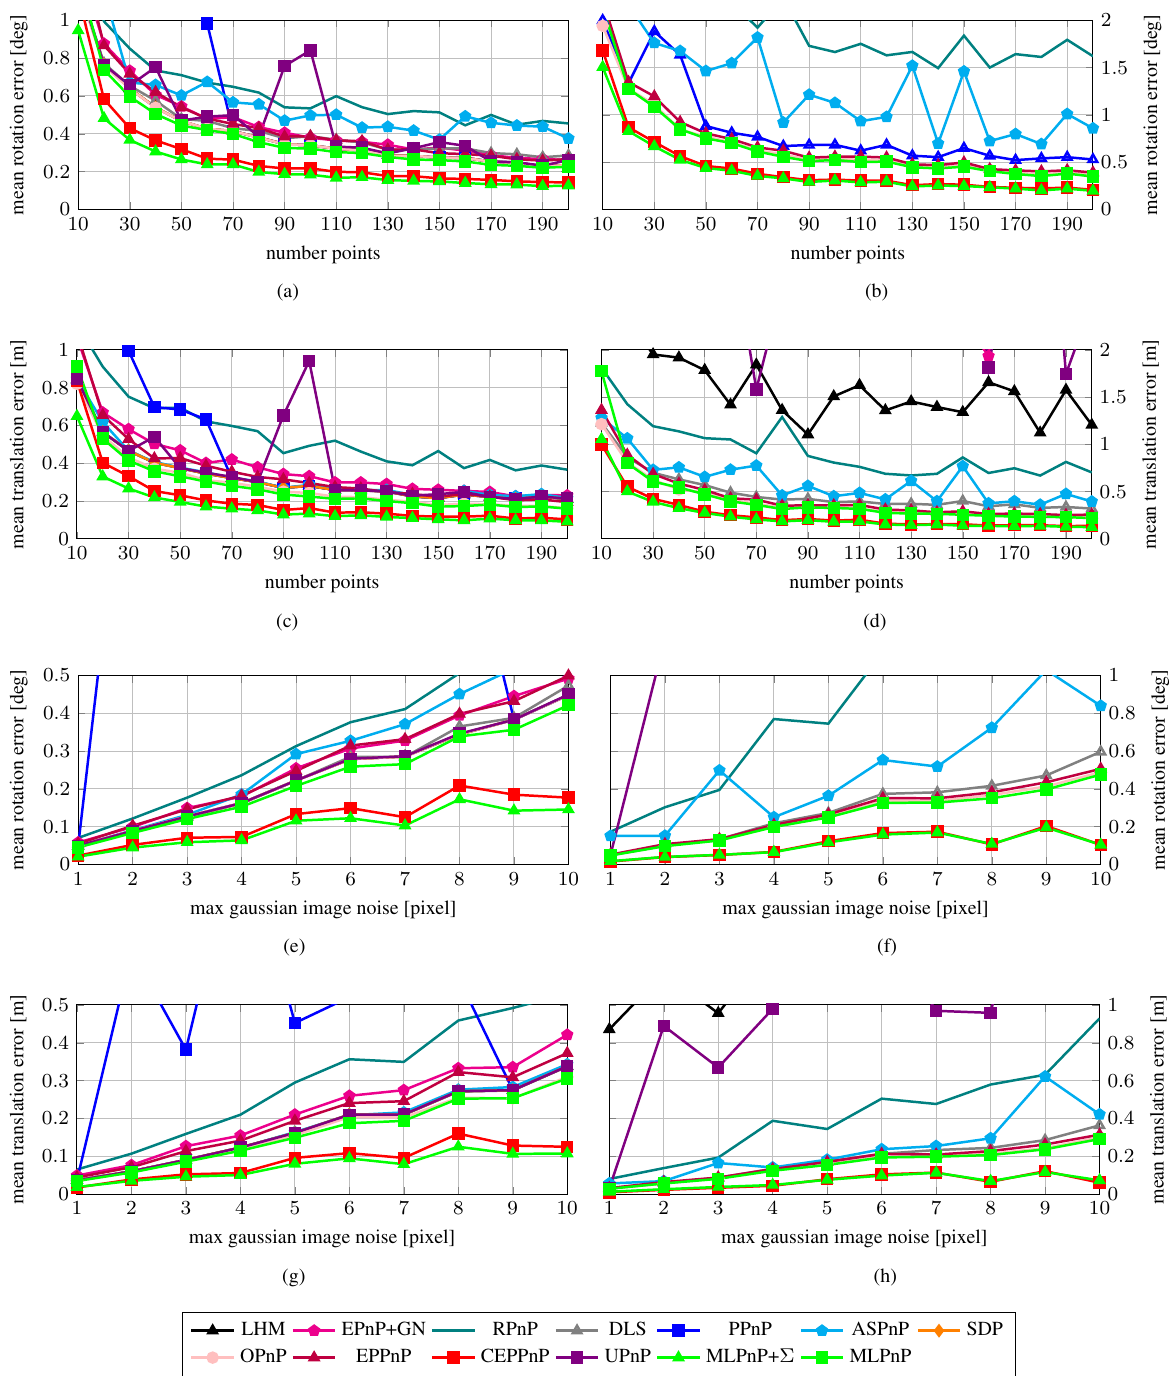
Figure 3. Left column ordinary 3D. Right column planar case. (a)-(d) increasing number of points. (e)-(h) 50 points fix, increasing noise level. CEPPnP and MLPnP+ Σ incorporate measurement uncertainty. All other algorithms assume that all points are measured with identical